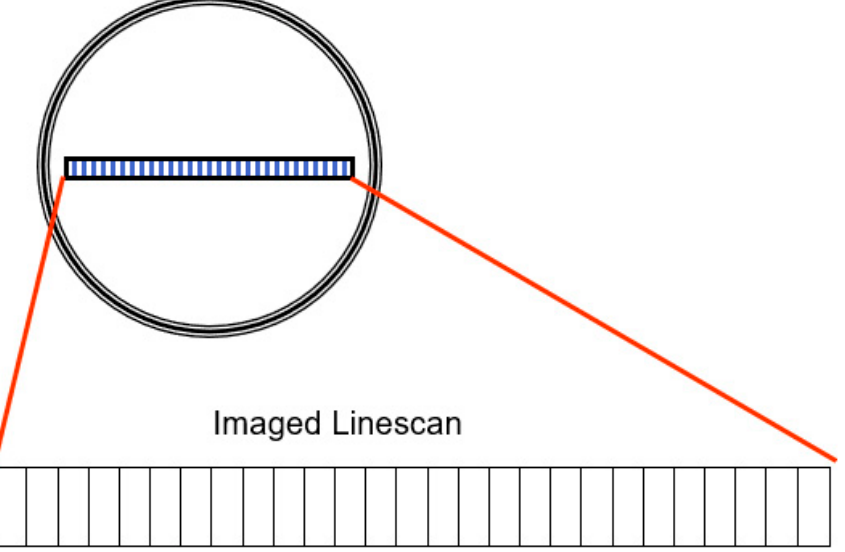
Figure 4. Array of SmartView camera, with single row of pixels.